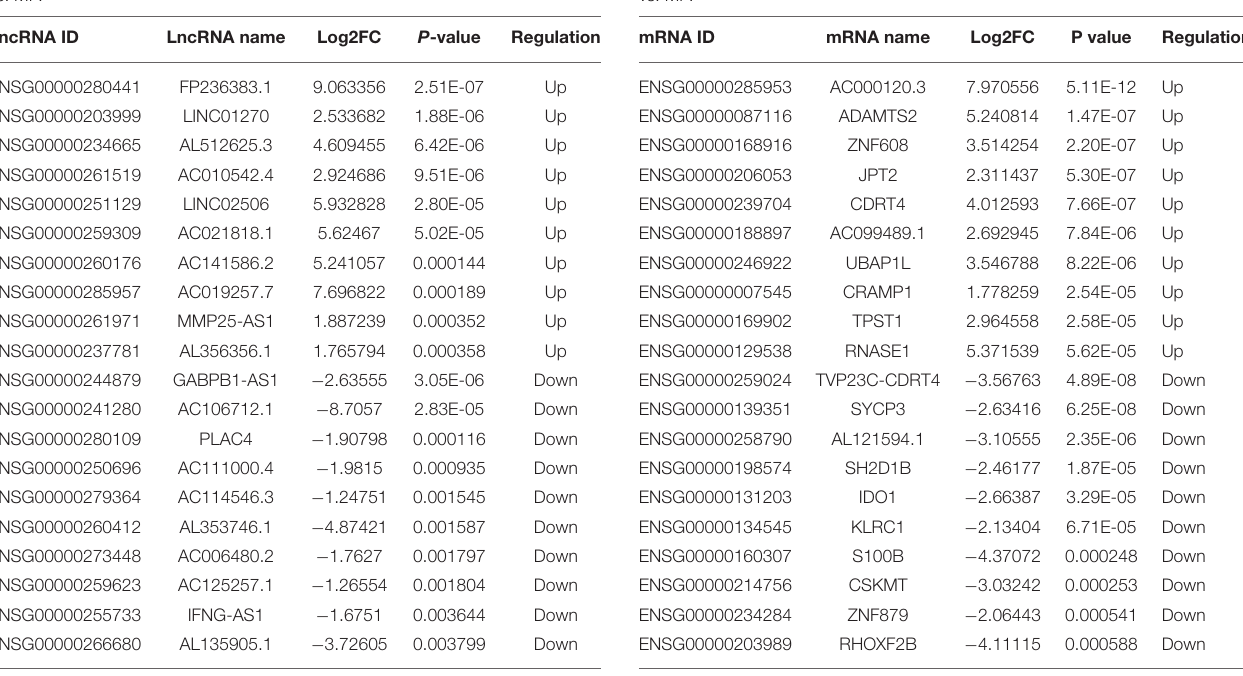
TABLE 4 | Top 10 up- and down-regulated differentially expressed lncRNAs in HF vs. MF.